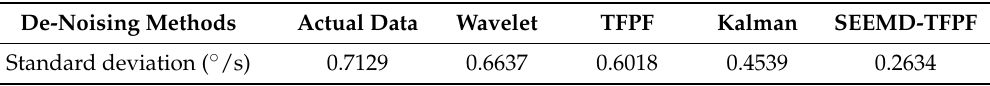
Table 1. SD comparison of different de-noising methods for rotation signal.